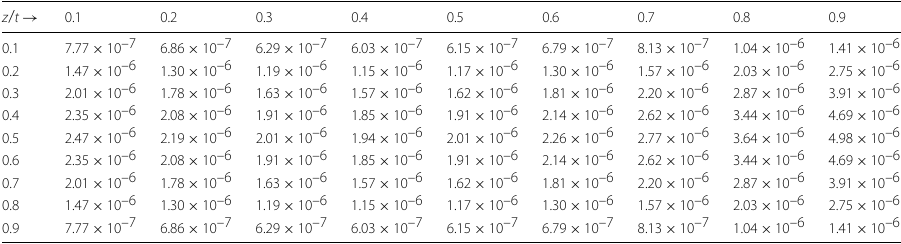
Table 3 Absolute errors for Example 1 by the proposed method at t = 1 when α = 0.7, N = 100, and (cid:3) t = 0.001